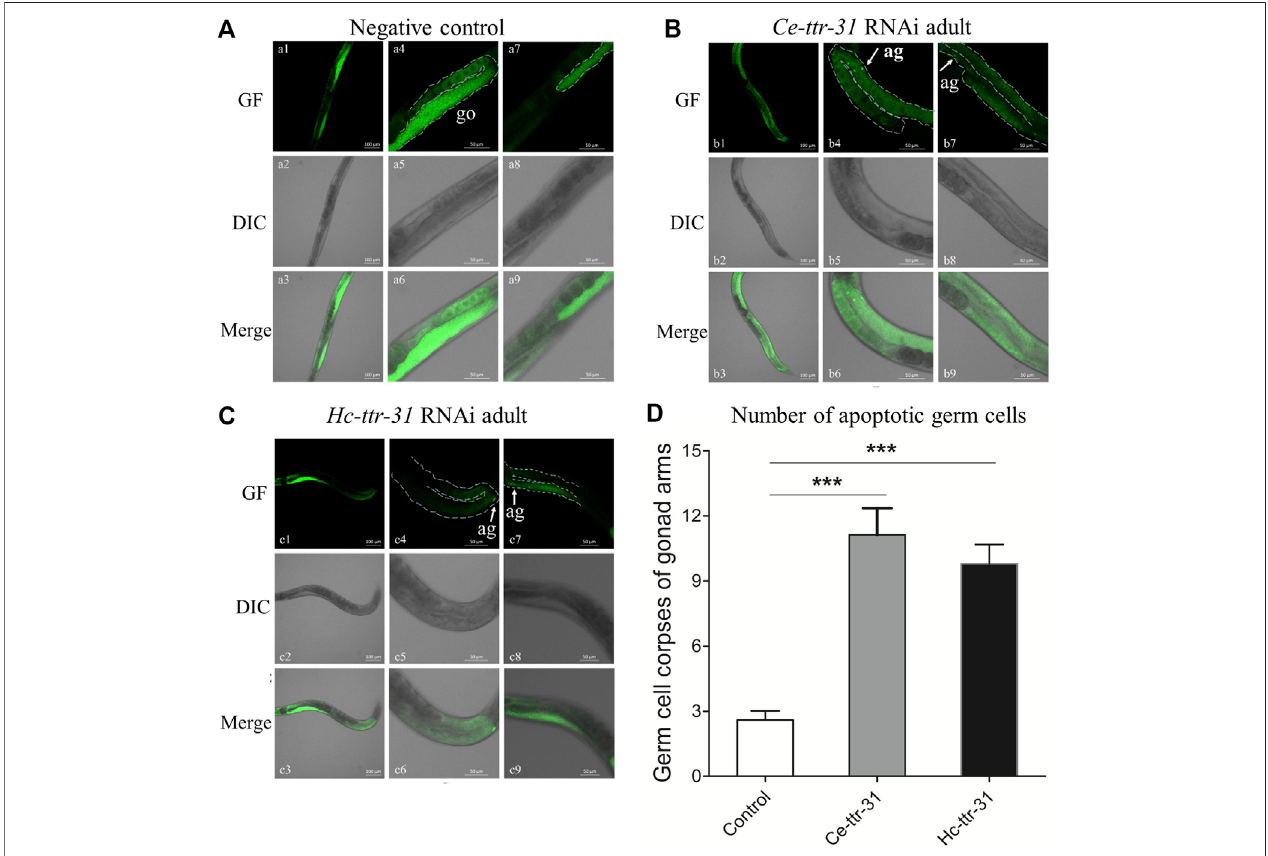
FIGURE6| Effectof ttr-31 RNAinterference onthegermcellsin Caenorhabditiselegans .Apoptoticgermcellsinthenegative control (A) , Ce-ttr-31 (B) and Hc-ttr- 31 (C) RNAi-treated worms are indicated. Apoptotic germ cells (ag) are pointed by white arrows. (A – C) a1-a3 shows the whole gonad of C. elegans stained by acridine orange including two gonad arms (a4-a6 and a7-a9). b4-b6 and b7-b9 are two gonad arms of a worm in b1-b3. c4-c6 and c7-c9 are two gonad arms of a worm in c1- c3. (D) Thenumberofapoptoticgermcellsinthetreatedanduntreatedwormsisshown.Dataarepresentedasmean ± SEM( n (cid:2) 15).GF:green fl uorescence;DIC: differential interference contrast; Merge: GF merges with DIC. Scale bars: 50 μ m *** p < 0.001.